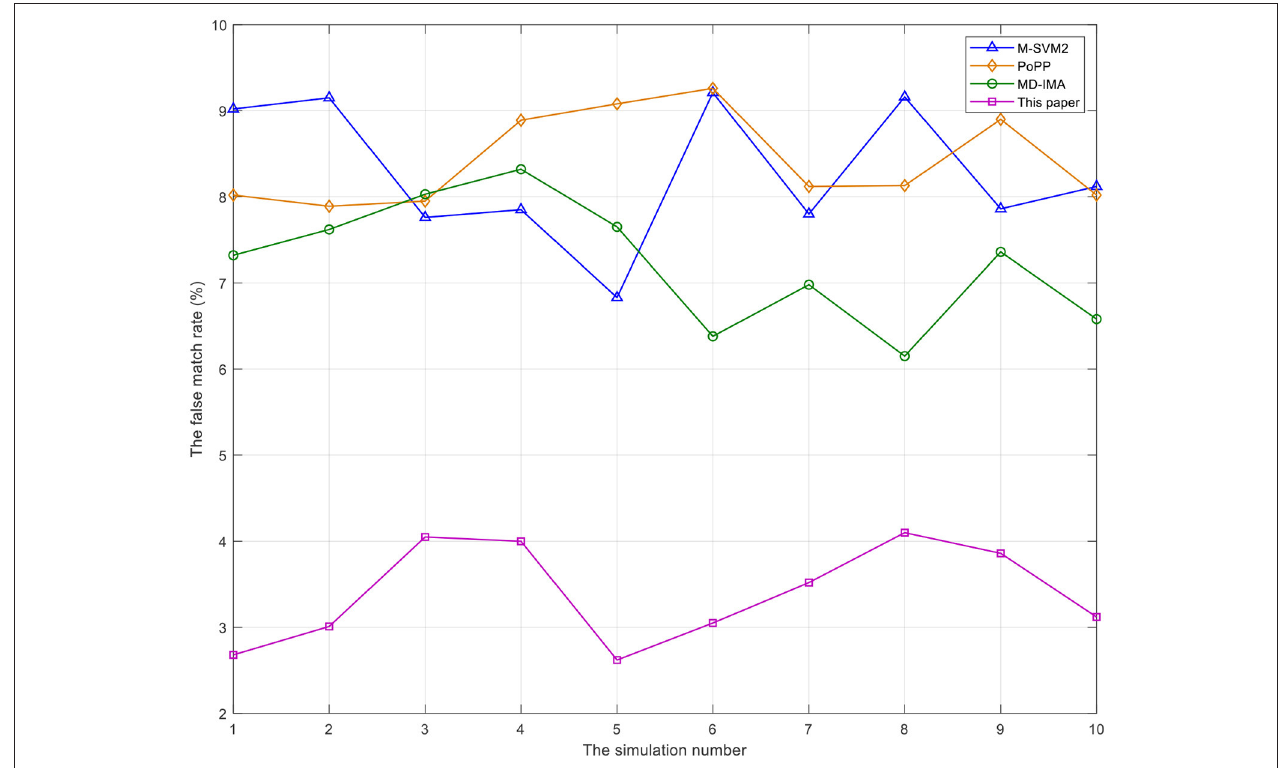
FIGURE 3 | The comparison of false match rate of mental state recognition of undergraduates in medical college by different methods.